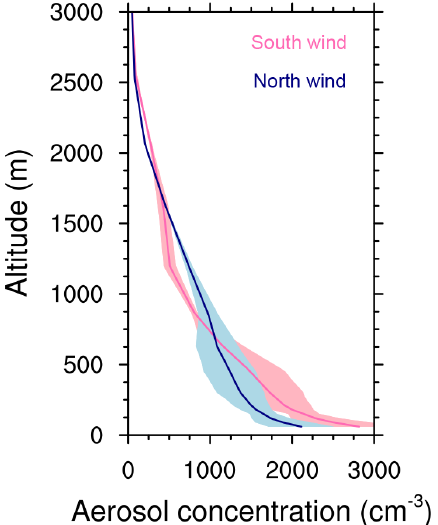
Figure 12. Vertical distributions of the aerosol number concen- trations (particle diameter of 0.15–2.5µm) under the prevailing southerly wind and northerly wind, respectively. The shaded areas indicate the error bars (standard